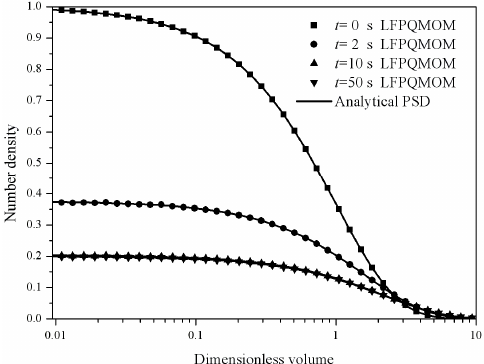
Figure 20. Particle size distributions at 0, 2, 10, and 50 s for the aggregation and breakage combined process with constant aggregation kernel, linear breakage kernel, uniform daughter distribution, and exponential initial PSD (square: numerical PSD at 0 s, Circle: numerical PSD at 2 s; up triangle: numerical PSD at 10 s; down triangle: numerical PSD at 50 s; line: analytical PSD).